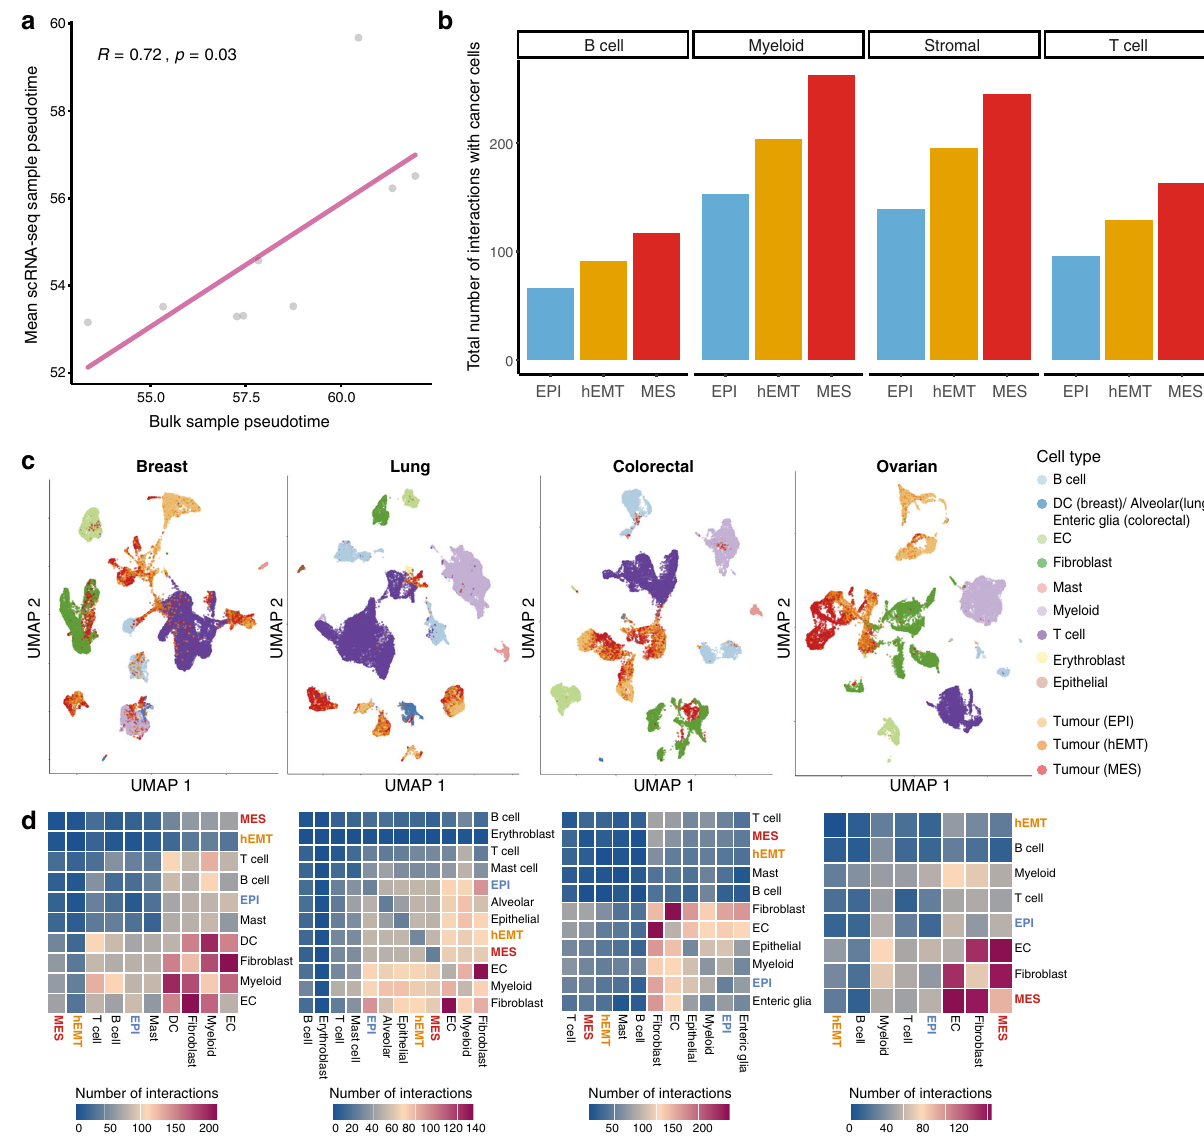
Fig.7|EMT diversityinsingle-celldata.a ComparisonbetweenEMTpseudotime estimates in matched bulk and single-cell samples from the same individuals (Pearsoncorrelationcoef fi cientRand p -valueareshown). b Numberofinteractions established between tumour cells found in an EPI, hEMT, or MES state and other cells in the tumour microenvironment in the Chung et al. 57 dataset. c Uniform Manifold Approximation and Projection (UMAP) reconstruction of single-cell expression pro fi les depicting the tumour and microenvironment landscape of